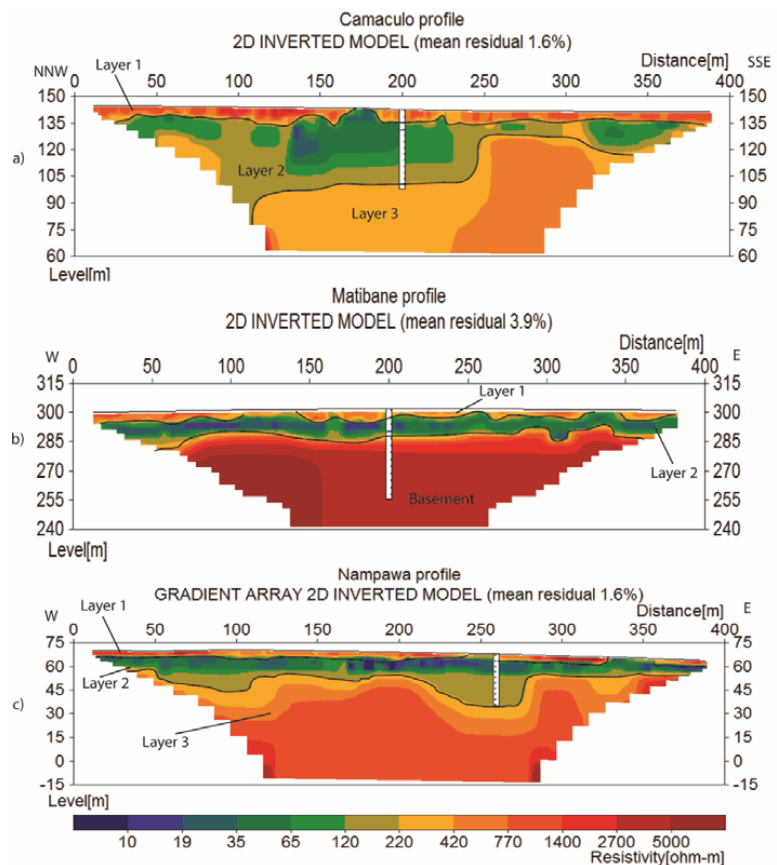
Figure 3. Three ERT profiles of 400 m showing three geophysical layers. ( a ) The NNW-SSE Camaculo profile with 45 m deep borehole located in the middle of the profile; ( b ) The W-E Matibane with 47 m deep borehole located in the middle of the profile; ( c ) the W-E Nampawa profile with a 33 m deep borehole located at 260 m in the profile [5].